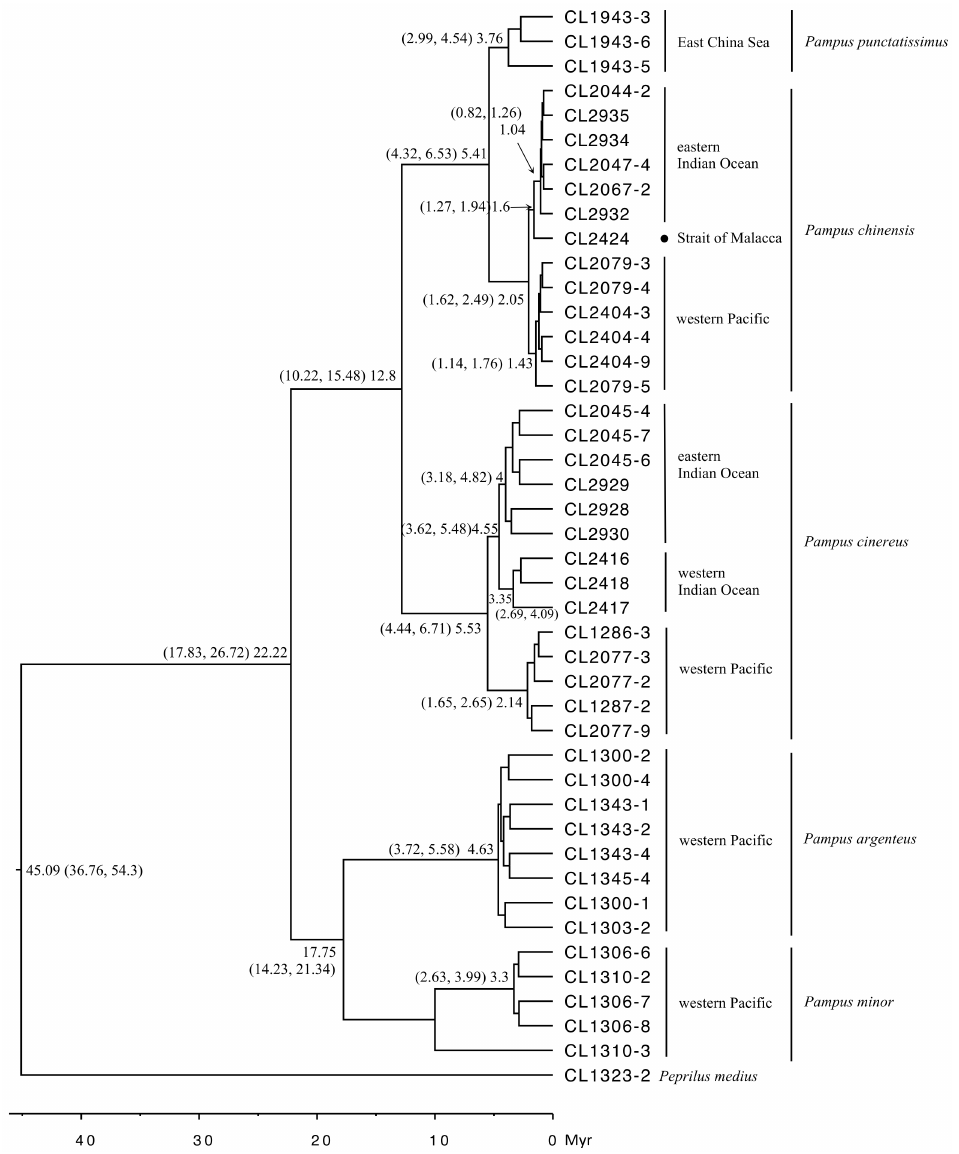
Figure 5. Time-tree of genus Pampus ; numbers beside the node indicate the estimated divergence time, and the numbers in parentheses indicate the 95% highest posterior density (HPD) intervals. The sea areas of collection are displayed. The time scale is million